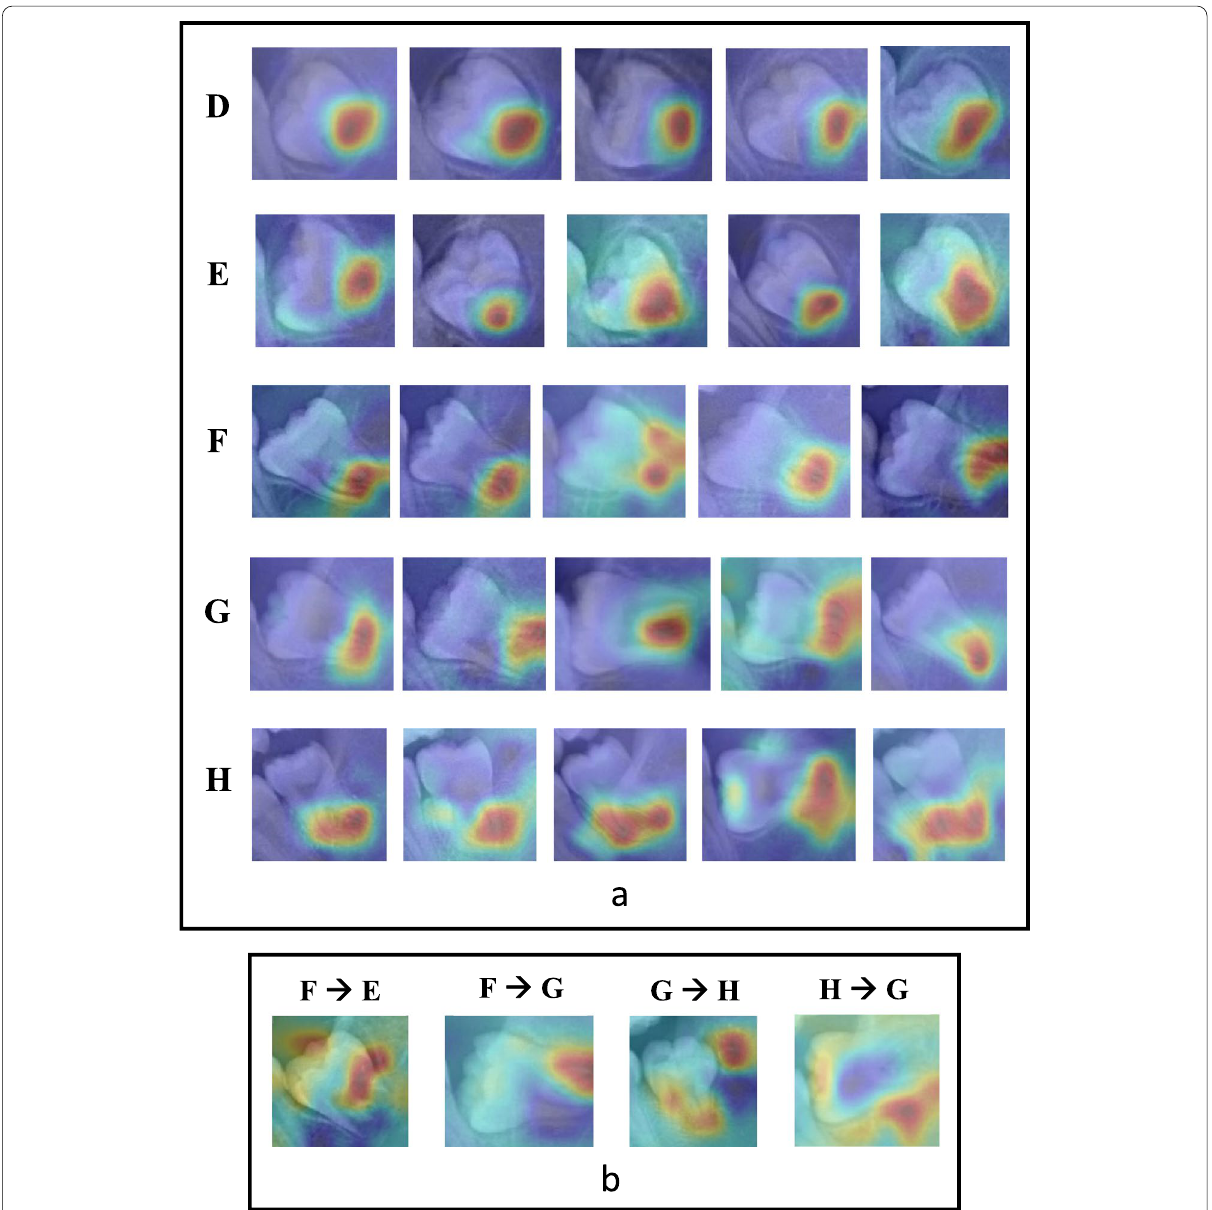
Fig. 4 Heat maps implemented using Grad-CAM. a Most specific positions focused on close to the root of the lower third molars and b examples of misclassification where the network focused on incorrect